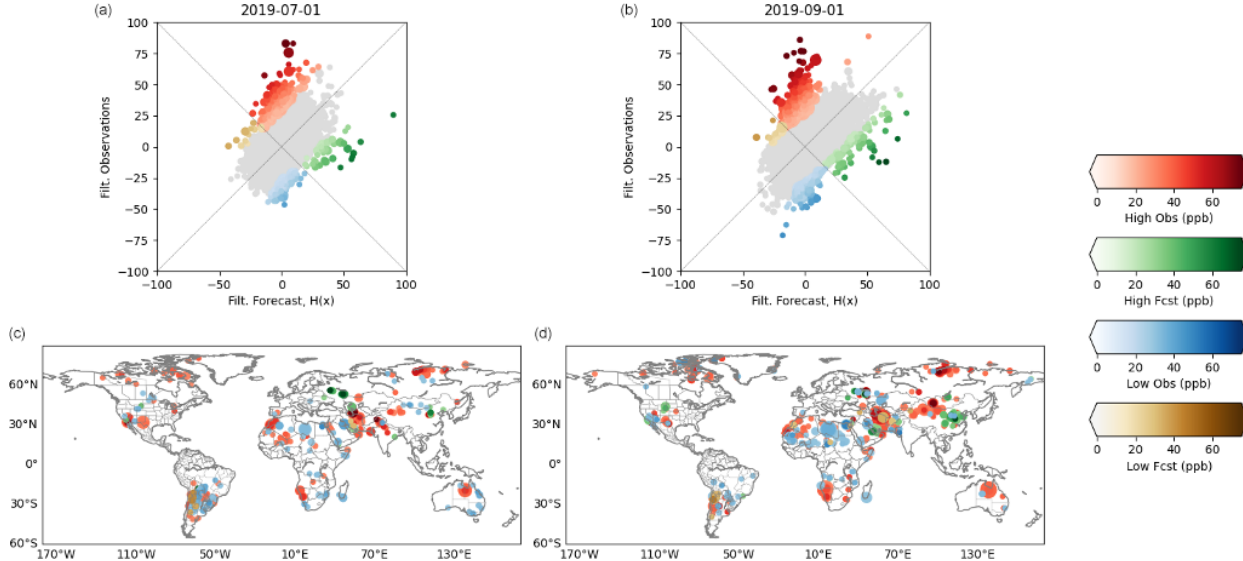
Figure 9. Examples of outlier classification. (a, b) Global distributions in the observation–first-guess space for two different 30d windows (end dates: 1 July and 1 September 2019). The four data classes are shown in different colours; the colour intensity reflects the number of outliers. (c, d) Locations of outlier classes around the globe during the two 30d windows (end dates: 1 July and 1 September 2019, respectively). Darker dots show larger departures. Larger dots indicate that more occurrences were detected in the bin and time window.